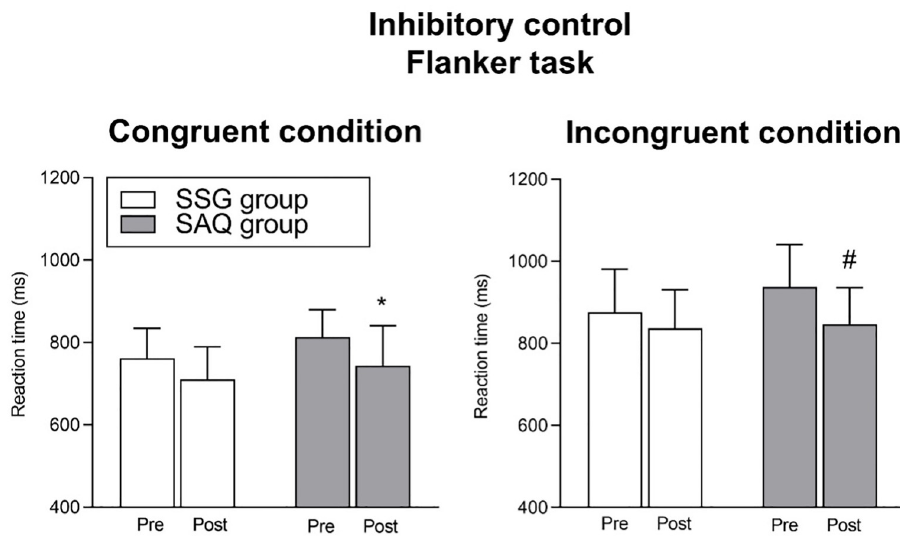
Fig 3. Effect of training intervention on inhibitory control (reaction time for congruent and incongruent condition in the Flanker task). Post < pre as from Bonferroni post-hoc tests: � P < 0.05; # P < 0.01.